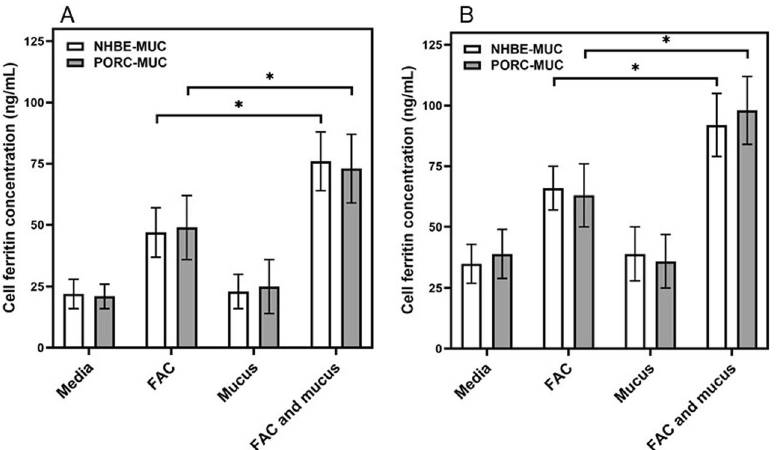
Figure 5. Cell ferritin concentrations after exposures to mucus and iron. With inclusion of either NHBE-MUC or PORC-MUC, cell ferritin concentrations were significantly increased in BEAS-2B cells ( A ) and THP-1 cells ( B ) relative to metal alone. Separate one way ANOVAs were employed for NHBE-MUC and PORC-MUC. *Increased relative to FAC (p <